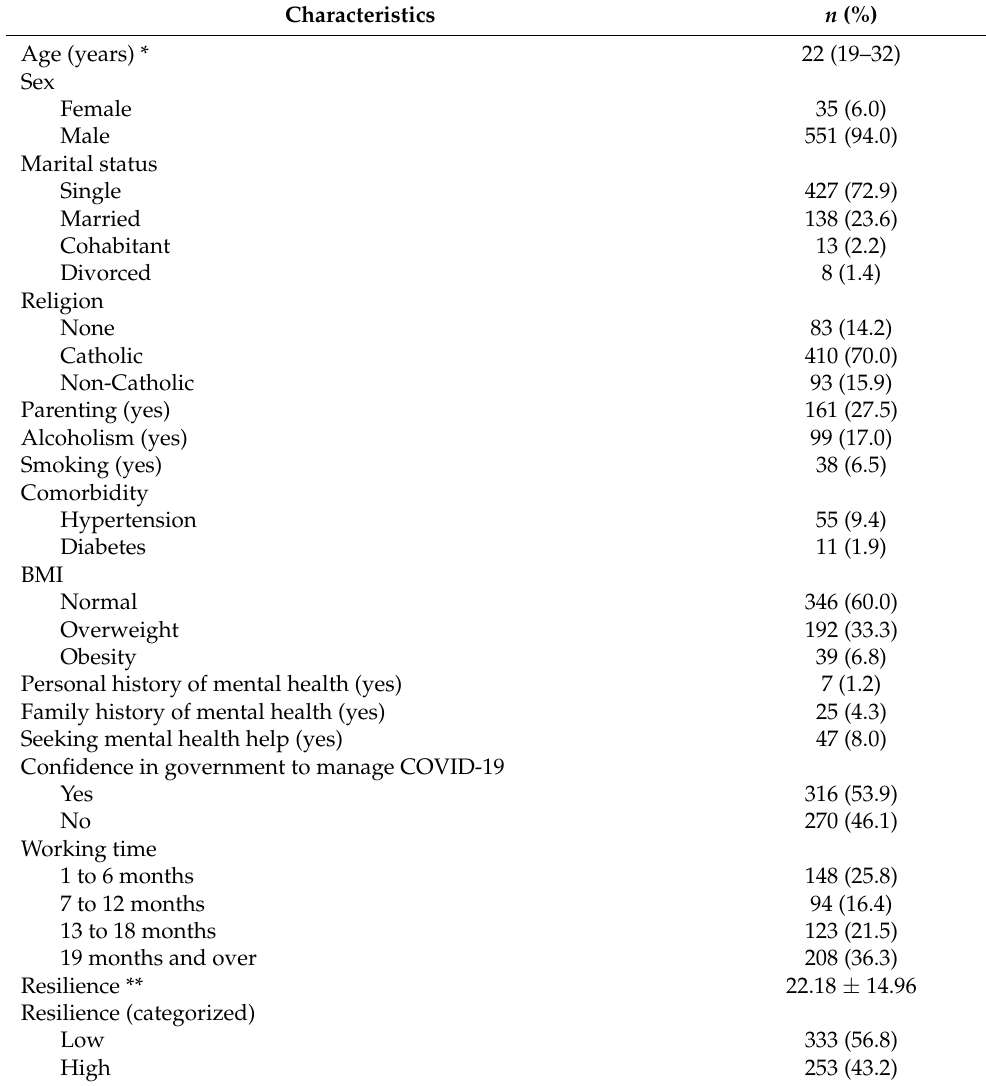
Table 1. Characteristics of participants ( n =